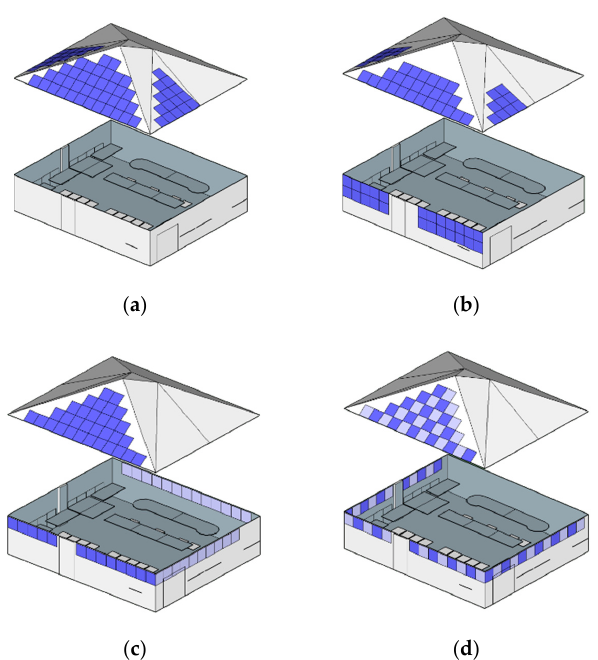
Figure 6. Proposed design solutions for the acoustic treatment in meeting room 2, for a total number of panels equal to 68. ( a ) 68 absorbers only are placed on three pitches of the hip vaulted ceiling; ( b ) 42 absorbers only are positioned on three pitches of the hip vaulted ceiling and 26 absorbers are placed on the rear wall; ( c ) 32 absorbers are positioned on one pitch of the hip vaulted ceiling, a row of 13 absorbers is placed on the upper part of the rear wall and a single row of 23 diffusers is placed on the front and one side walls; ( d ) absorbers and diffusers are alternated on one pitch of the hip vaulted ceiling and on the upper part of three side walls.